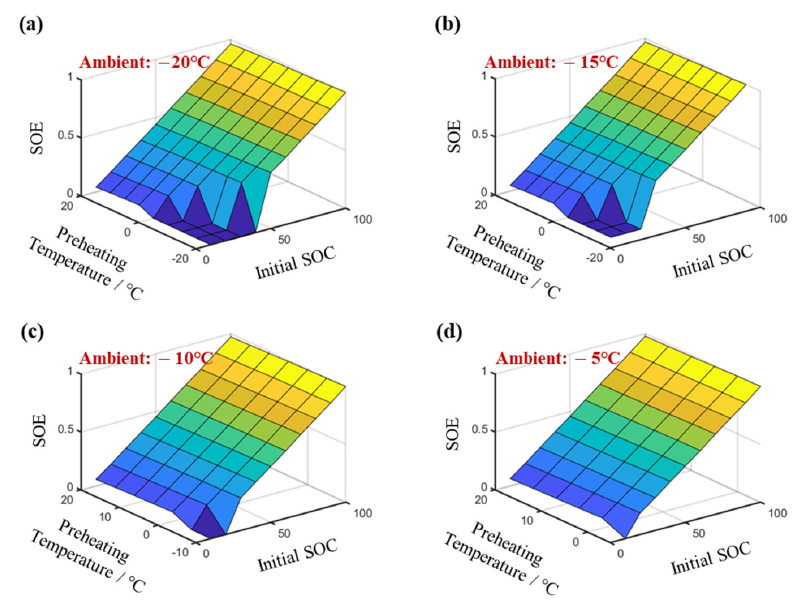
Figure 11. The effect of preheating to energy state at various low temperatures. ( a ) Ambient tem- perature and battery initial temperature is − 20 ◦ C. ( b ) Ambient temperature and battery initial tem- perature is − 15 ◦ C. ( c ) Ambient temperature and battery initial temperature is − 10 ◦ C. ( d ) Ambient temperature and battery initial temperature is − 5 ◦ C.